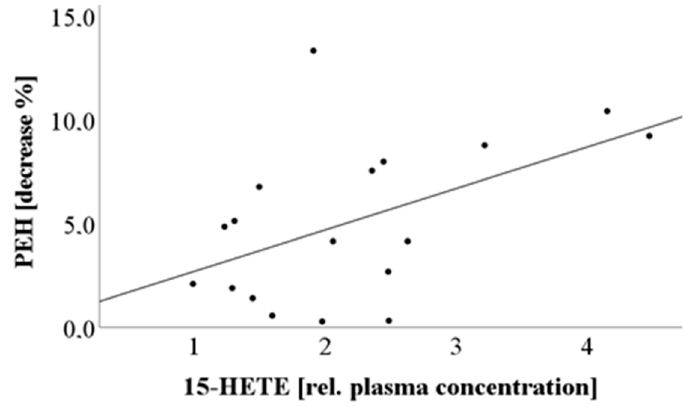
Figure 5. Pearson Correlation of 15-HETE plasma levels versus PEH; fold-change in 15-HETE plasma level (% decrease compared to baseline at 10 min after cessation of exercise) versus PEH.